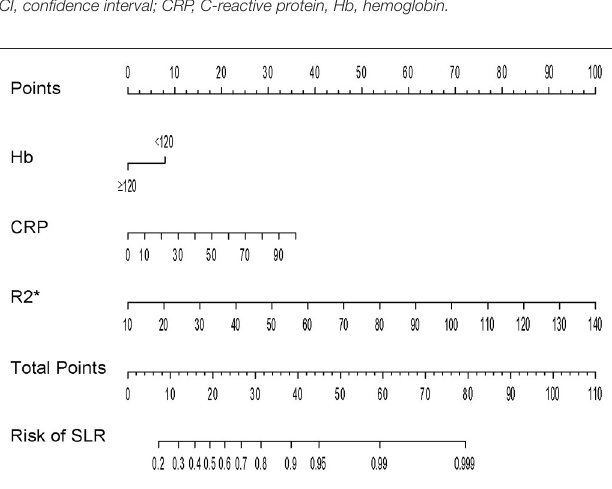
FIGURE 4 | Nomogram for identification of secondary loss of response in patients with Crohn’s disease.